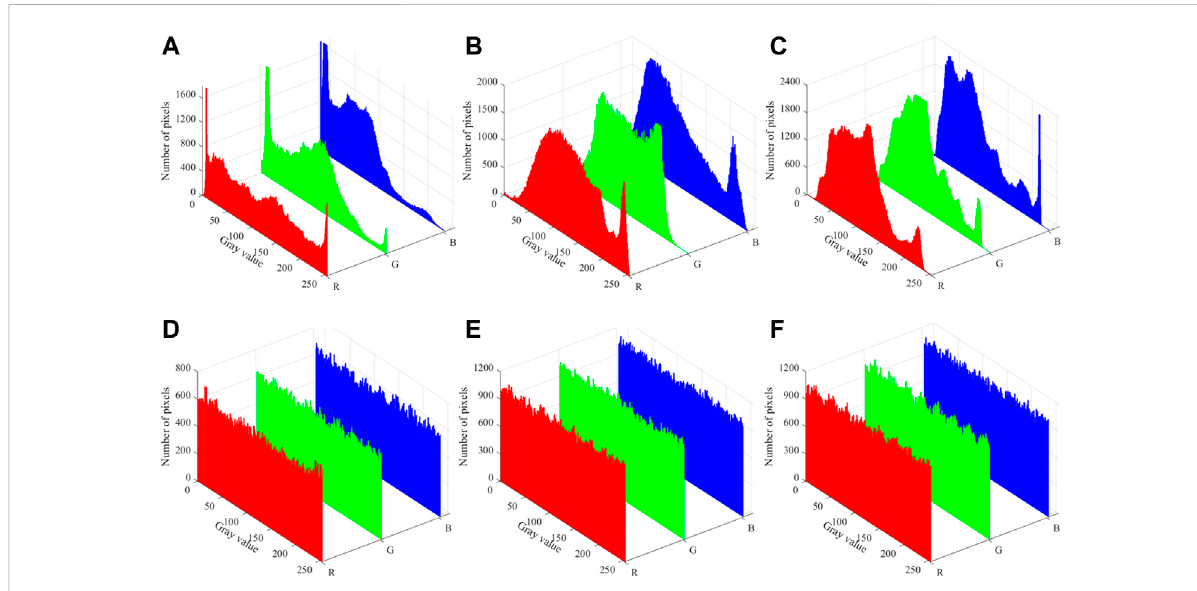
FIGURE 15 Histograms of plaintext images and ciphertext images: (A) “ Girls, ” (B) “ Sailboat, ” (C) “ Goldhill, ” (D) “ Girls, ” (E) “ Sailboat, ” (F) “ Goldhill. ”